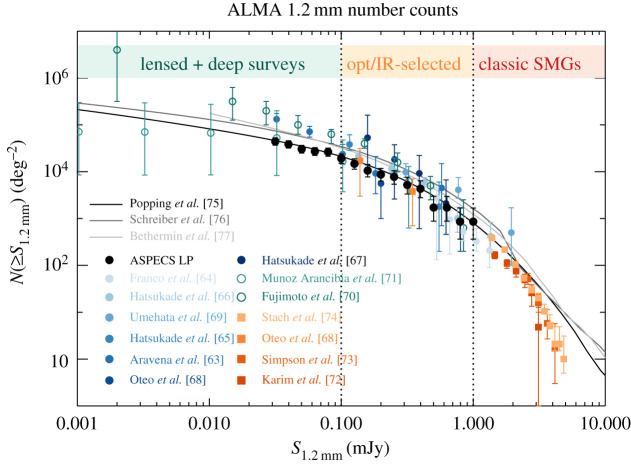
The range of flux density detections enabled by ALMA, as illustrated by the current state-of-the-art 1.2 mm number counts, following the compilation of González-López et al. [62]. The filled circles are number counts derived from deep blind fields, cluster fields and calibration fields [62–69]). The open circles extend in depth thanks to the inclusion of gravitationally lensed sources [70,71]. The orange to red filled squares correspond to ALMA follow-up of single-dish detected bright sources at 870 μm [68,72–74], with the conversion from 870 μm to 1.2 mm flux density following González-López et al. [62]. The grey lines show the number count predictions from the semi-empirical models of Popping et al. [75], Schreiber et al. [76] and Béthermin et al. [77]. We highlight three main regimes that this review focuses on: the bright end (S1.2 mm≳1 mJy), corresponds to ‘classic SMGs’ (§2); the flux density range S1.2 mm≃0.1–1 mJy tends to be the realm of pre-selected galaxy surveys (typically in stellar mass or star formation rate; such surveys are discussed in §3); and the faint end (S1.2 mm < 0.1 mJy) is now being probed for the first time thanks to deep surveys with ALMA, as discussed in §4.